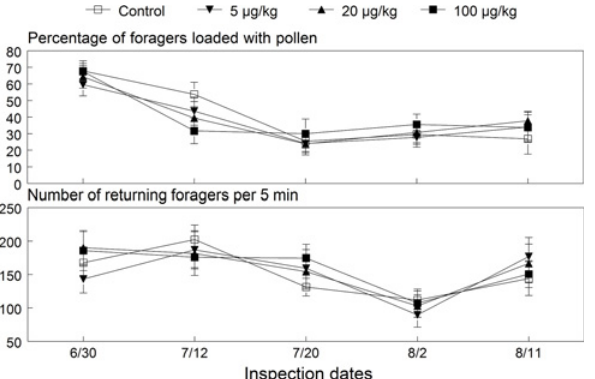
Fig 8. Mean ( ± SE) percentage of foragers with pollen pellets and the number of foragers returning to the 2010 colonies exposed to untreated or imidacloprid-spiked diet patties. ANOVA results for the percentage loaded with pollen (dose: F (3, 42.6) = 0.85, p = 0.473; date: F (4,81.7) = 18.93, p < 0.001; interaction: p = 0.520) and number of foragers (dose: F F (12,82.2) = 0.93, 0.001; interaction: F (12,80.9) = 0.71, p = 0.742).